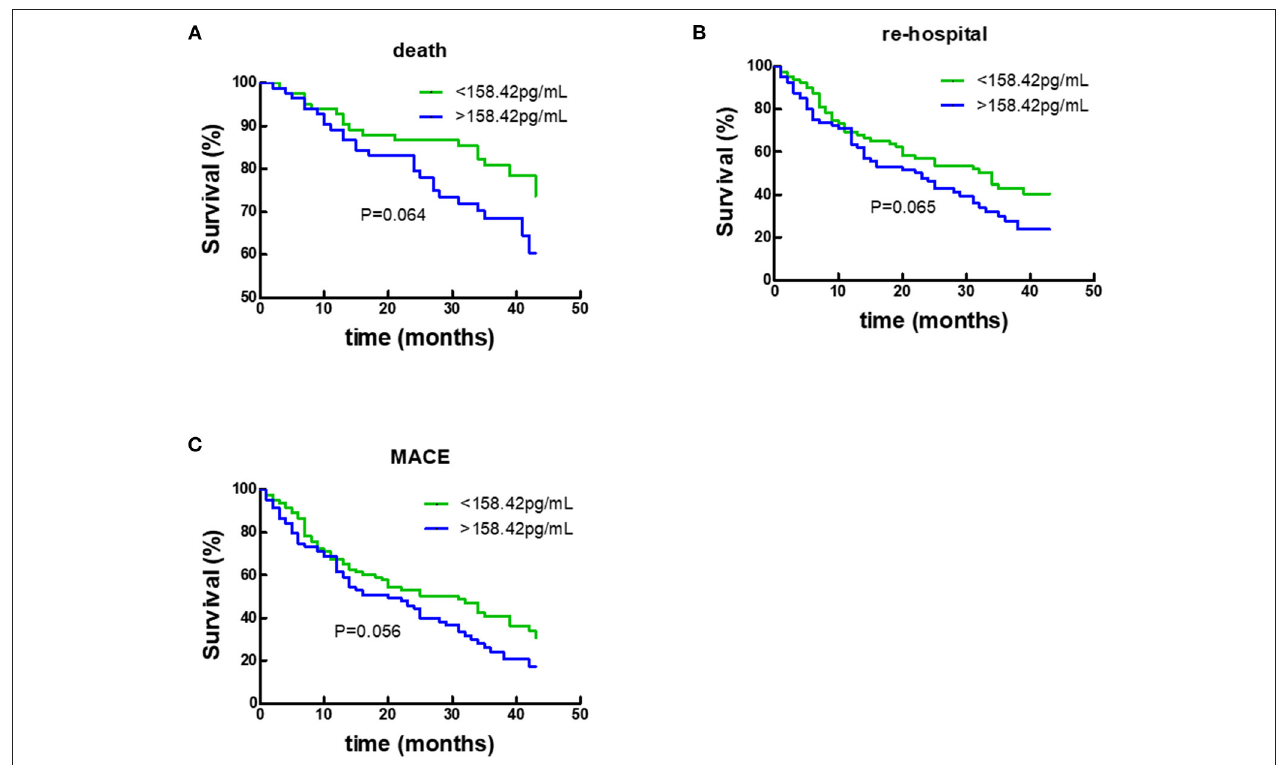
FIGURE 4 | Kaplan–Meier survival curves according to baseline plasma Gal-3 levels in all HF subjects. (A) Death rates according to higher of lower baseline plasma Gal-3 levels. (B) Re-hospitalization rate according to higher of lower baseline plasma Gal-3 levels. (C) Composite-endpoint event rates according to higher of lower baseline plasma Gal-3 levels. Gal-3,